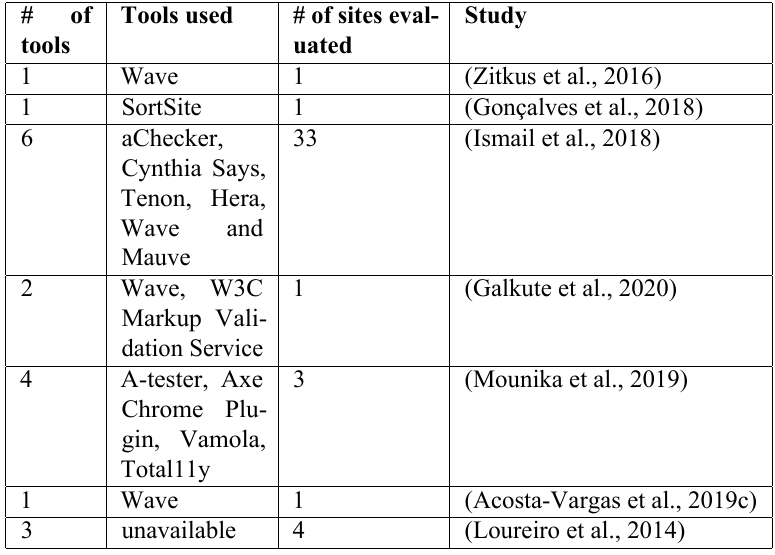
Table 2. Automated tools used in the web studies